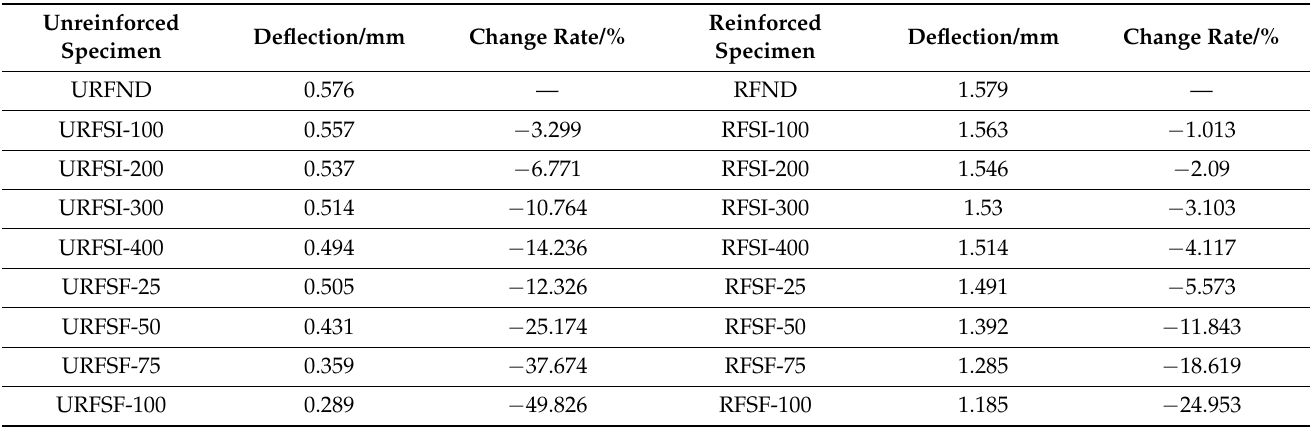
Table 9. Deflection of concrete flexural specimen. Table 8. Flexural strength of concrete flexural specimen.